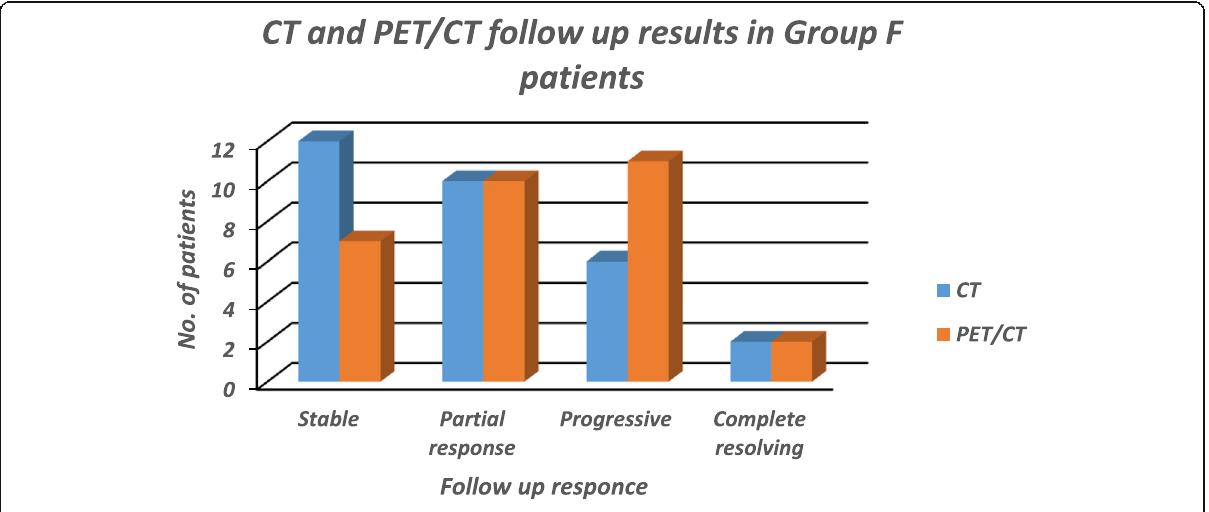
Fig. 3 Demonstrates the CT and PET/CT follow-up results between patients of group F